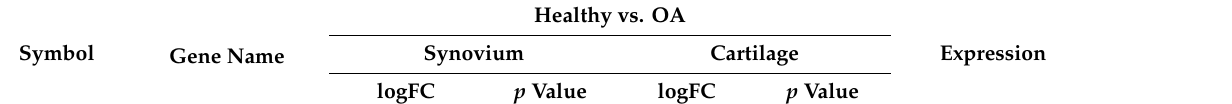
Table 1. Ten common DEGs related to “inflammation